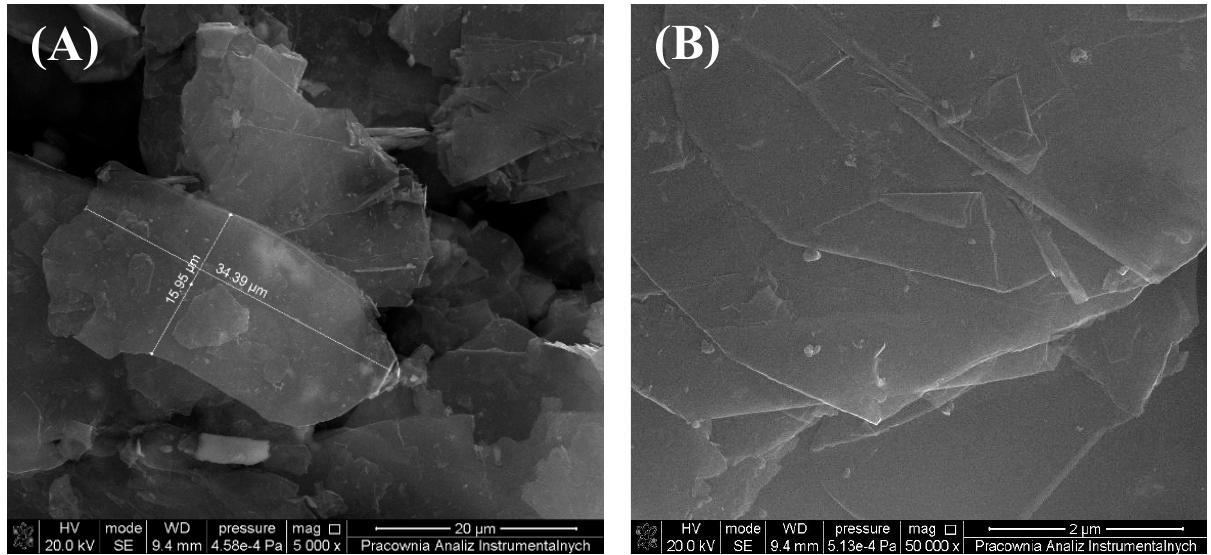
Figure 1. SEM images of graphite with magnification ( A ) 5000 × and ( B ) 50,000 × . The morphology of shungite is presented in Figure 2A,B.